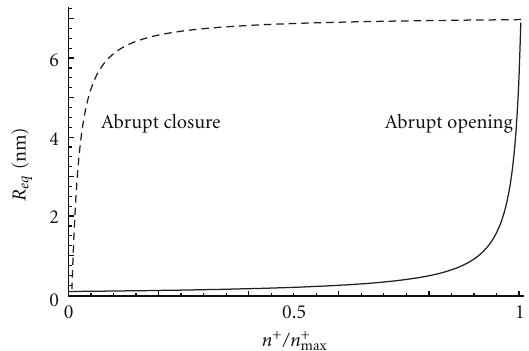
Figure 4: The relationship between the equilibrium radius of the pore ( R eq ) and the relative cation concentration in the vesicle ). The relationship between n + /n + and R eq is derived from ( n + /n + max max the minimization of the membrane bending energy. Note that an increase in the cation concentration (bold line) leads to an abrupt increase in the fusion pore radius, R eq (i.e., the opening of the fusion pore), while, in the opposite direction (dotted line), a reduction in the cation concentration leads to an abrupt closure of the fusion